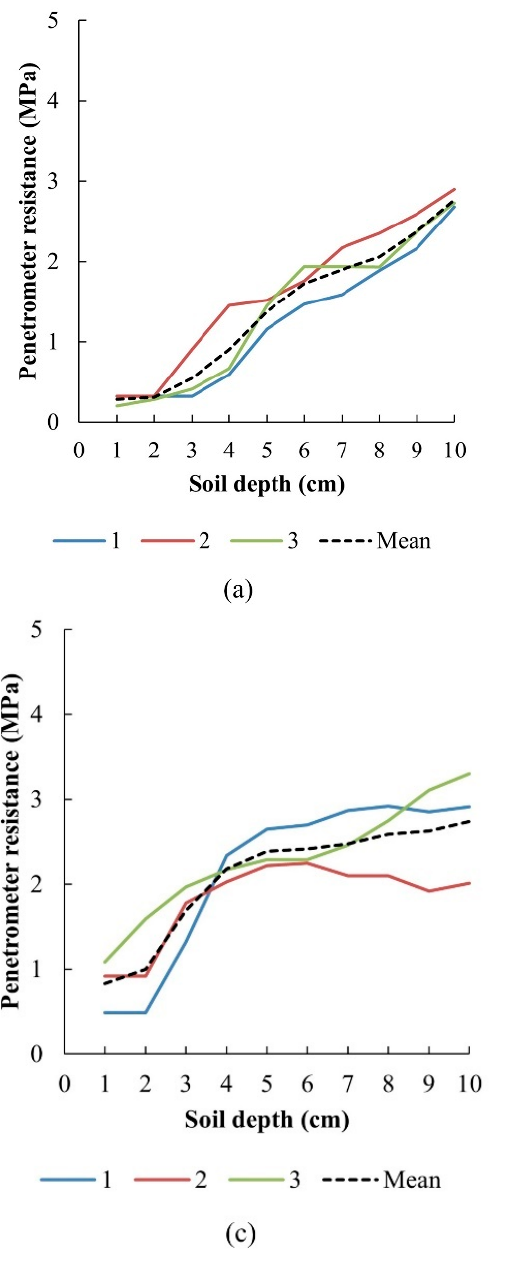
Figure 16. Penetrometer resistance measured three times: ( a ) outside the tire track, ( b ) one passage, ( c ) two passages, ( d ) three passages.